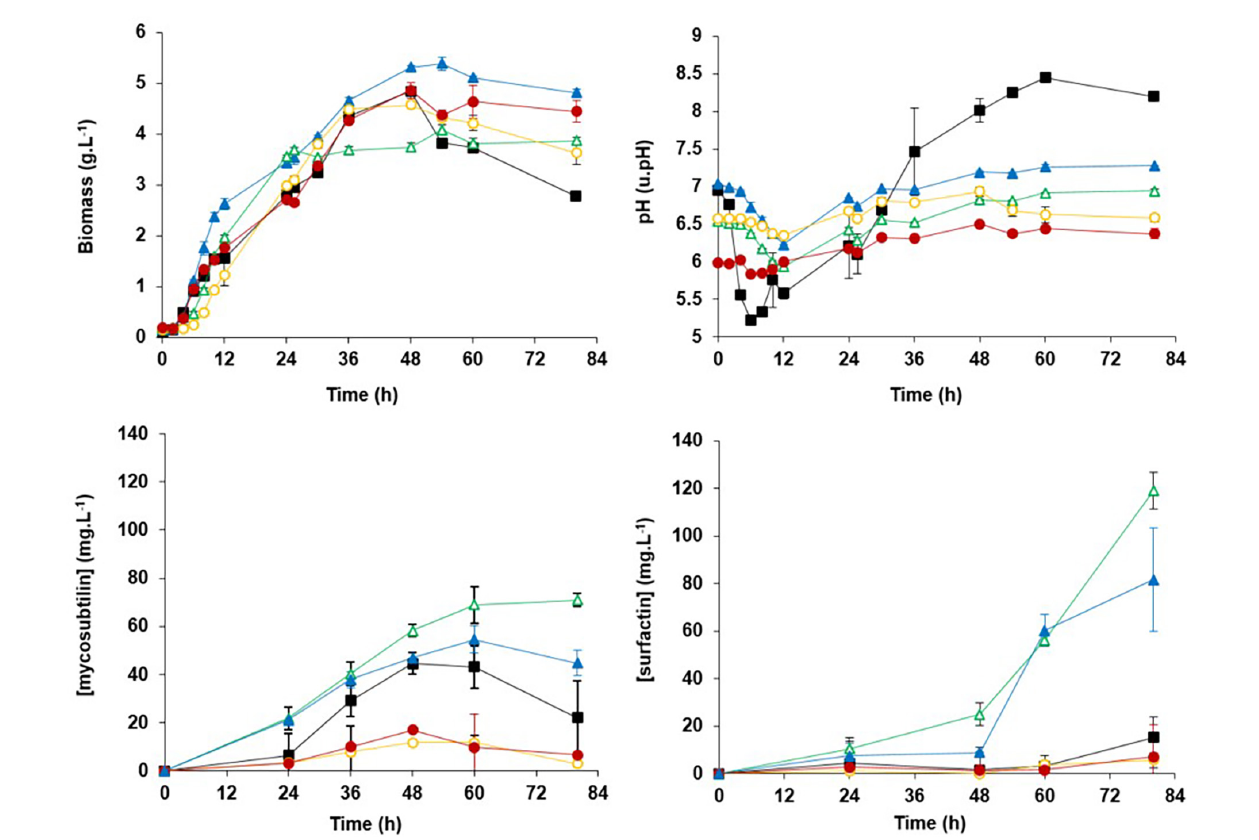
FIGURE 3 | Biomass, pH, production of mycosubtilin, and surfactin kinetics for Bacillus subtilis American Type Culture Collection (ATCC) 6633 flasks cultures at 30 ◦ C in the Landy medium ( (cid:4) ) or in the Landy medium buffered with 100 mM of 3-( N -morpholino)propanesulfonic acid (MOPS) at pH 7.0 ( (cid:78) ) or at pH 6.5 ( (cid:52) ) or with 100 mM of 2-( N -morpholino)ethanesulfonic acid (MES) at pH 6.5 ( ◦ ) or at pH 6.0 ( • ). Measurements are given as means from triplicates of independent cultivations with standard